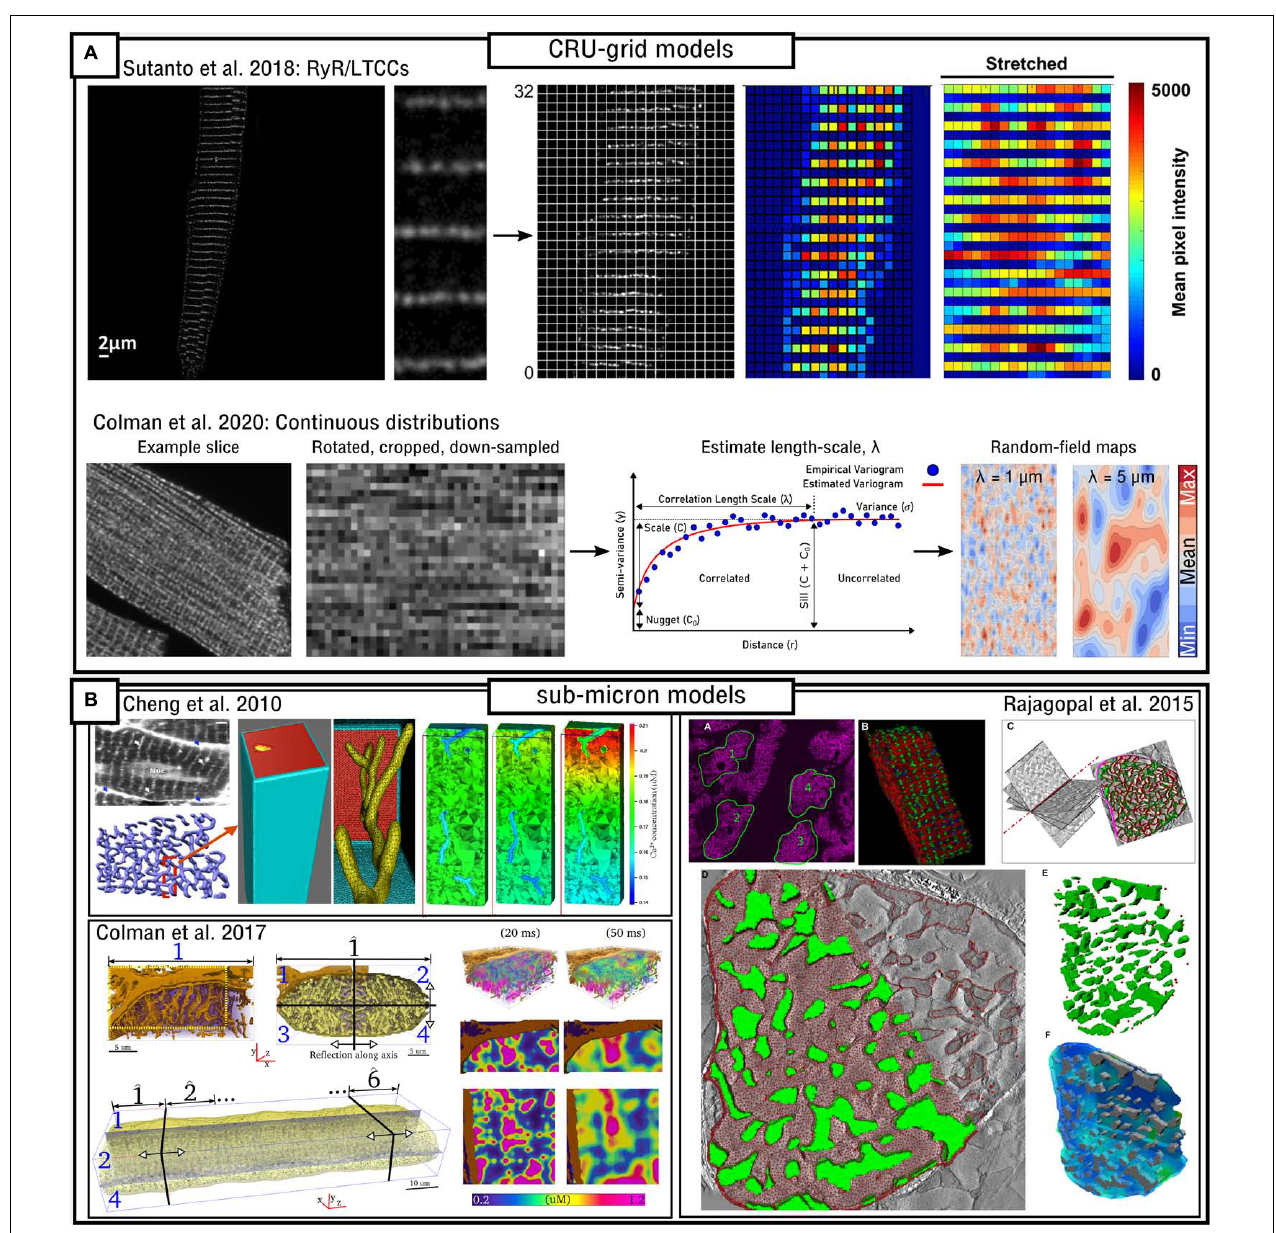
FIGURE 7 | Image-based modeling approaches. (A) Approaches for image-based modeling in idealized, CRU-grid cell models. The top panel illustrates the processing of LTCC/RyR image data so that it can be aligned and registered on an idealized grid computational model, as presented in Sutanto et al. (2018). The lower panel illustrates the method of calculating the correlation length-scale ( λ ) in order to generate Gaussian-random field maps which match these parameters in order to describe sub-cellular heterogeneity, as presented in Colman et al. (2020). (B) Approaches for directly incorporating imaging data into realistic, sub-micron cell models. The top-left panel demonstrates processing of ultra-structural data describing T-system structure into a mesh for simulations, and illustrates the large Ca 2 + gradients that can occur under different flux-distributions, as presented in Cheng et al. (2010). Lower panel illustrates processing of data describing the T-system and SR in a portion of a cell, approaches to tesselate the cell portion into a whole-cell, and the substantial Ca 2 + -gradients observed in this model also, as presented in Colman et al. (2017b). Right panel illustrates the semi-automated pipeline for segmenting multiple structures, including the myofibrils and mitochondria, into a 3D structurally-detailed representation of a sarcomere, as presented in Rajagopal et al.